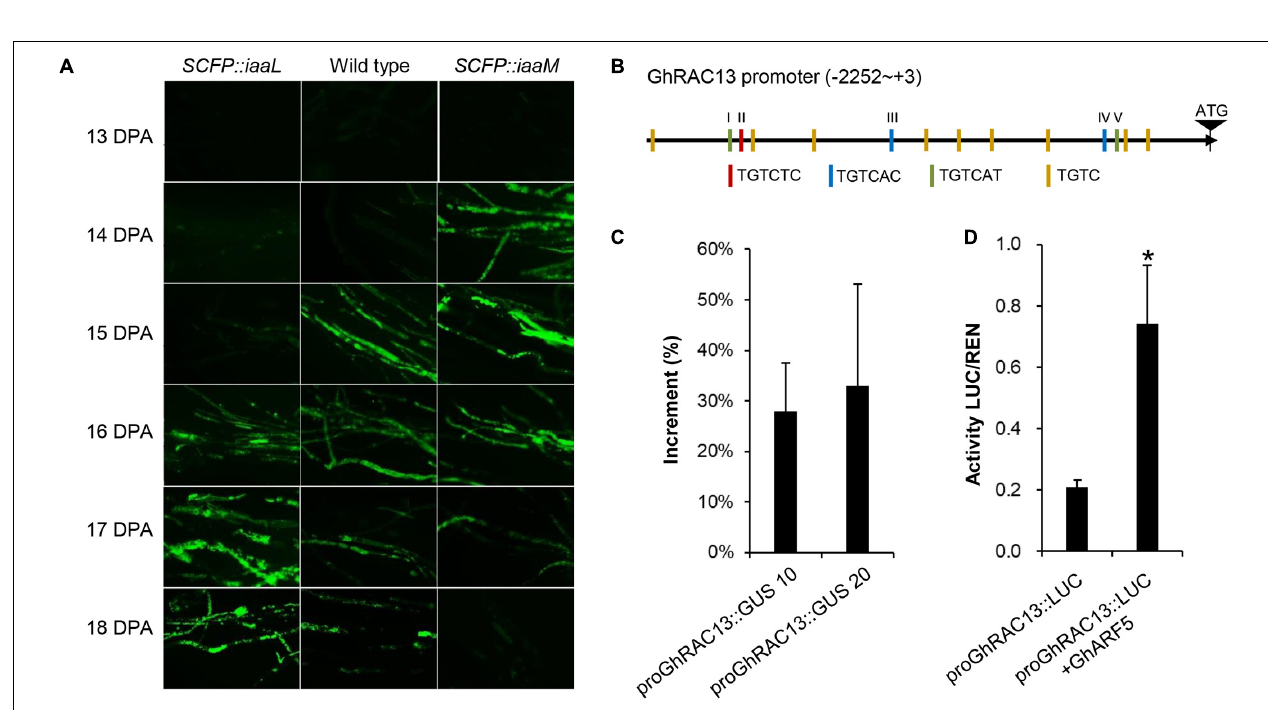
FIGURE 6 | Auxin causes earlier occurrence of GhRAC13-mediated ROS generation in cotton fibers. (A) ROS generation occurred earlier in transgenic fibers with higher indoleacetic acid (IAA) levels. (B) Diagram of AuxREs in GhRAC13 promoter. (C) Activity of GhRAC13 promoter was upregulated by IAA treatment. (D) GhRAC13 promoter was activated under the expression of GhARF5. Error bars indicate standard deviation based on three biological replicates. Asterisks indicate significant difference as determined by Student’s t -test ( P < 0.05).